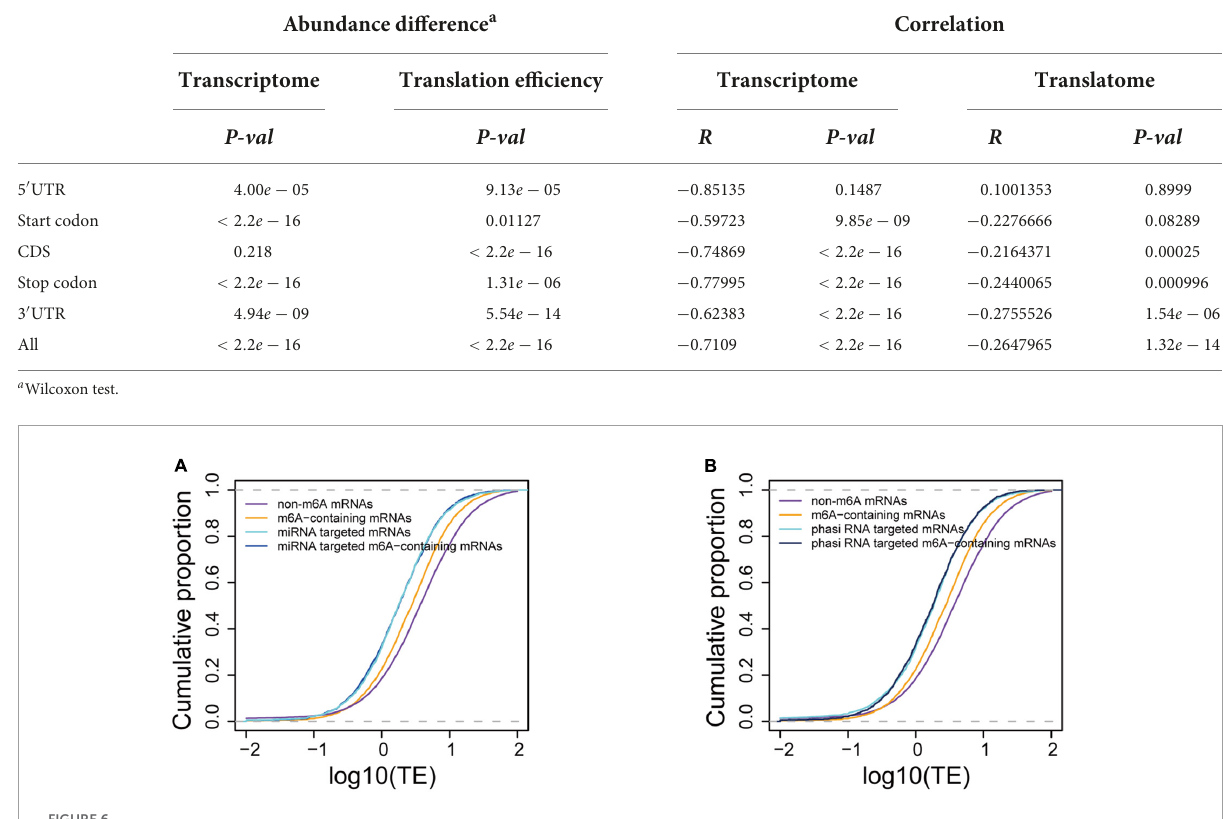
FIGURE6 Comparison of translation suppression effects between m6A methylation and small RNA binding. (A) Comparison of translation efficiencies between m6A-containing, miRNA targeted, and m6A-containing mRNAs targeted by miRNA. (B) Comparison of translation efficiencies between m6A-containing and phasiRNA targeted